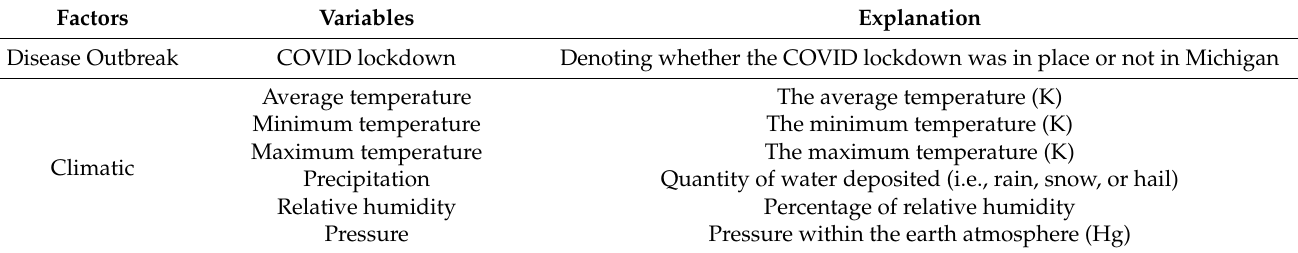
Table 2. Exogenous